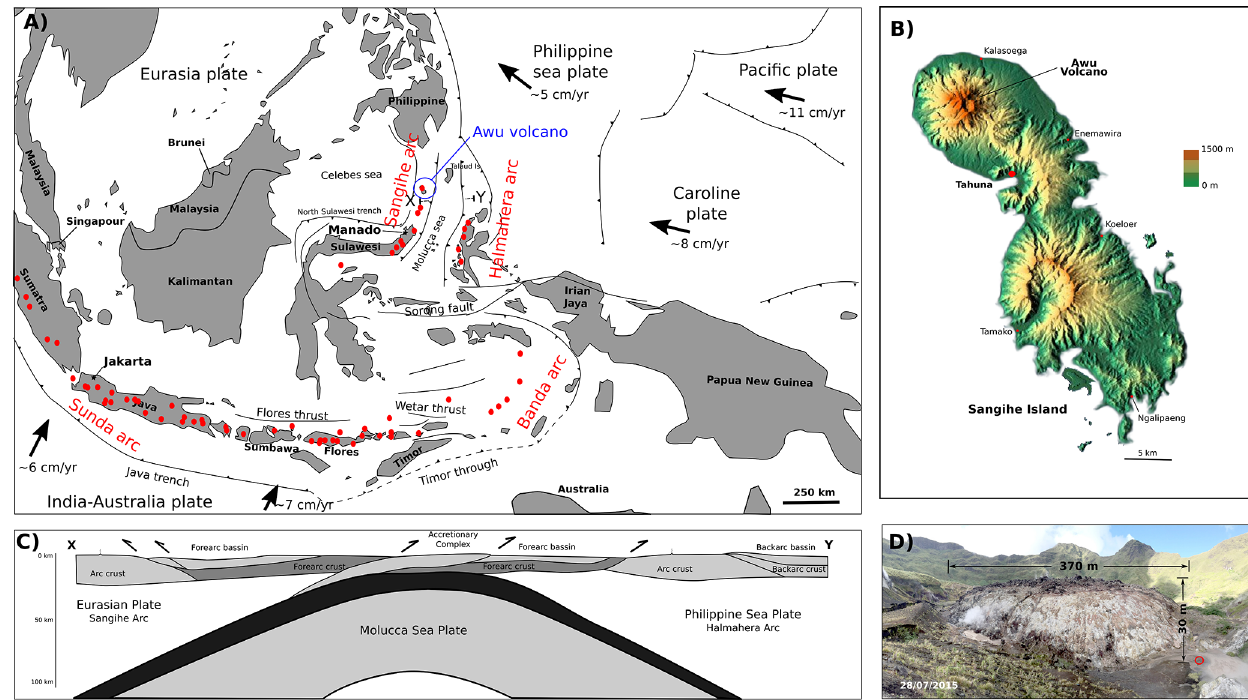
Figure 1. Awu volcano is the northernmost active volcano of the Sangihe arc (a) . It occupies the northern portion of the Sangihe Islands (b) . The 3D map is from https://maps-for-free.com (last access: 8 August 2020). Sangihe and Halmahera arcs constitute the present-day example of arc-to-arc collision (c) . The Molucca Sea plate that existed between the two arcs is now sinking deeper beneath the Molucca Sea. Awu’s crater is currently occupied by a lava dome (d) . Note the person circled in red for